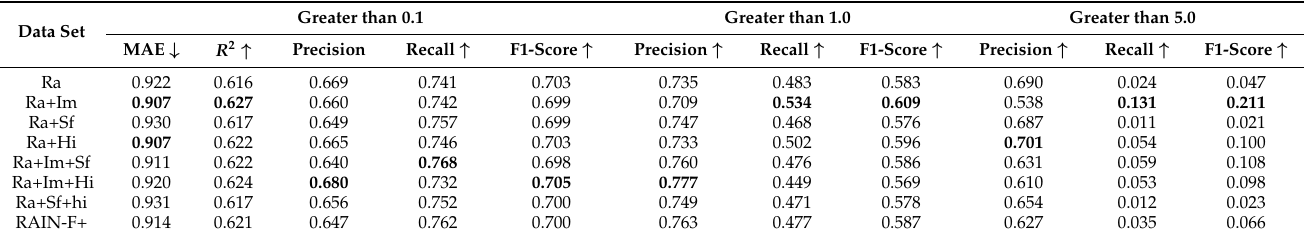
Table 1. Evaluation results for precipitation prediction in next one hour with the resolution of 256 × 256. Data Set